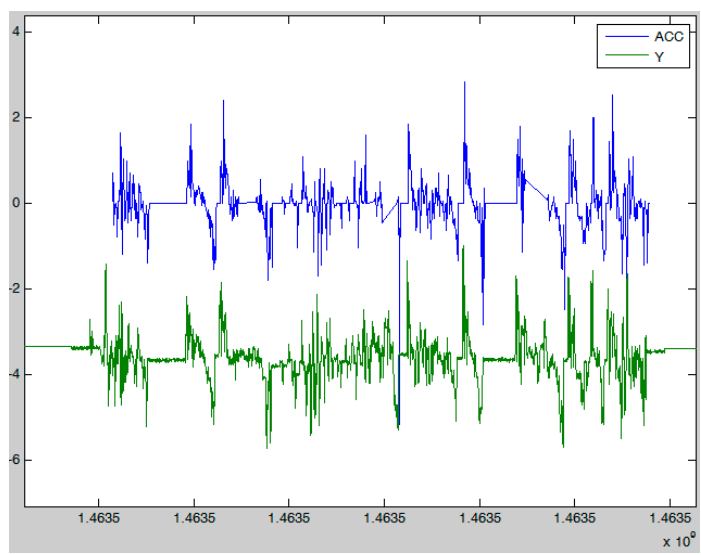
Figure 3. Acceleration calculated from GPS data and Y axis values from smartphone accelerometer.